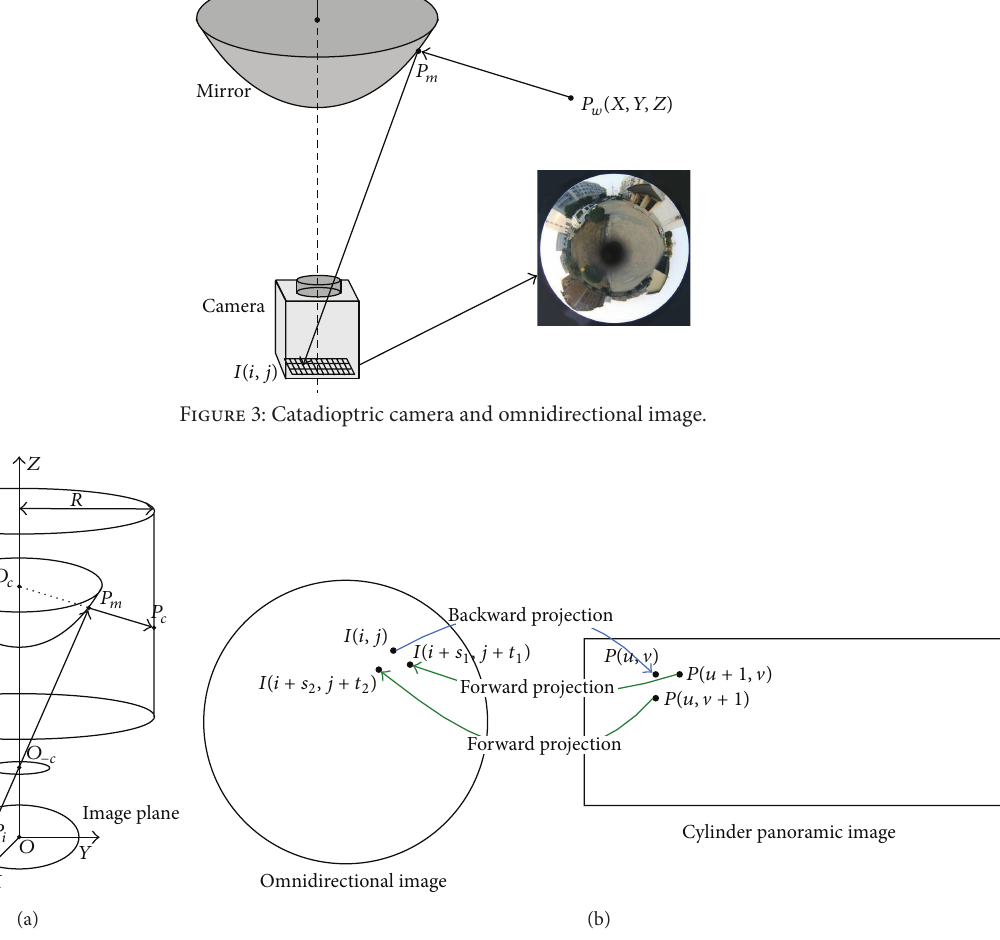
Figure 4: Sketch map of Omni-TV computation: (a) backward projection; (b) Omni-TV computation method.